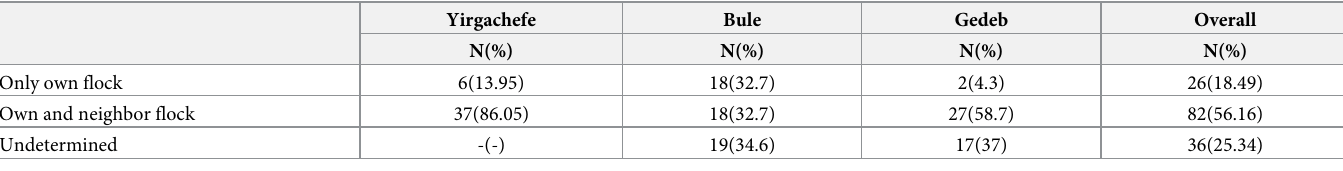
Table 2. Farmers’ breeding ram mating patterns.